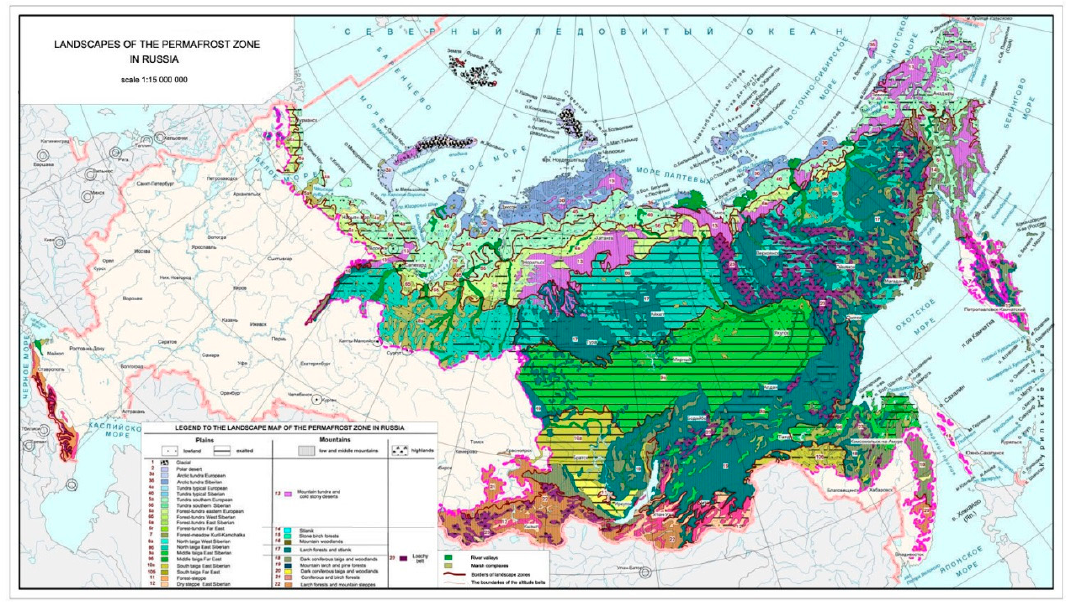
Figure 5. Landscape map of the permafrost zone in Russia. Geosciences 2019 , 9 , 353